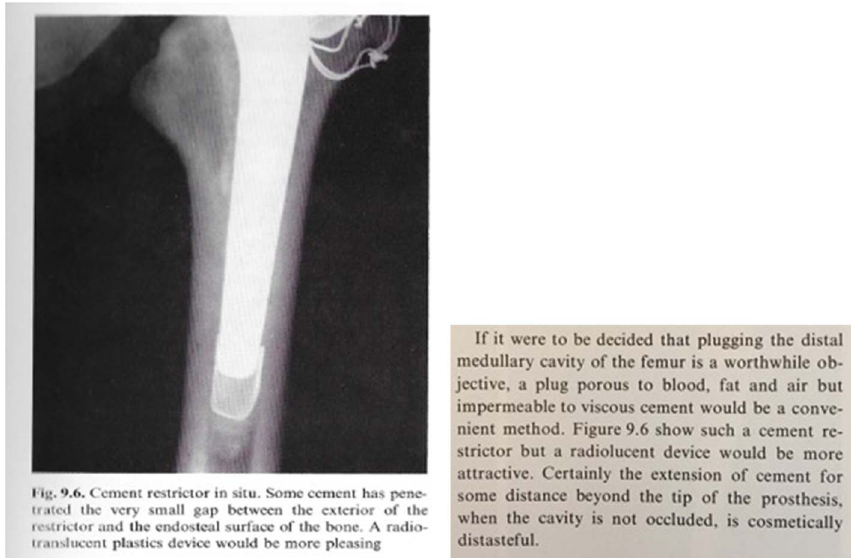
Figure 1. Pictures from LFA J Charnley (1979, p.